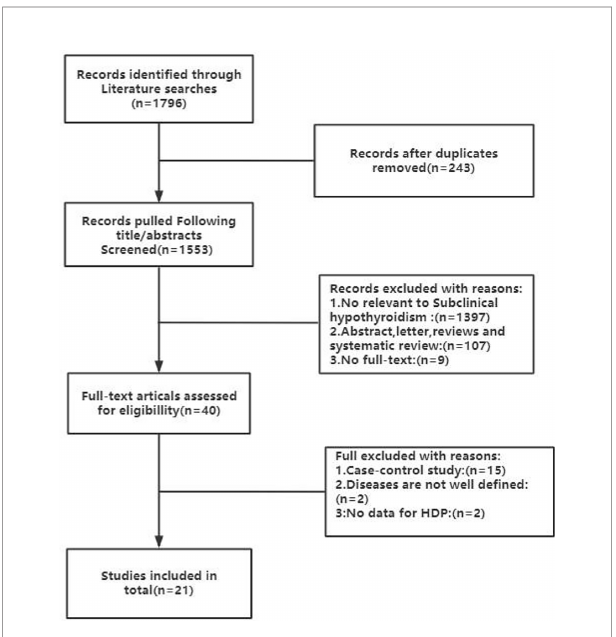
FIGURE 1 | Flow chart of the literature search and selection process in the MEDLINE (PubMed), EMBASE, Cochrane Central, Web of Science and